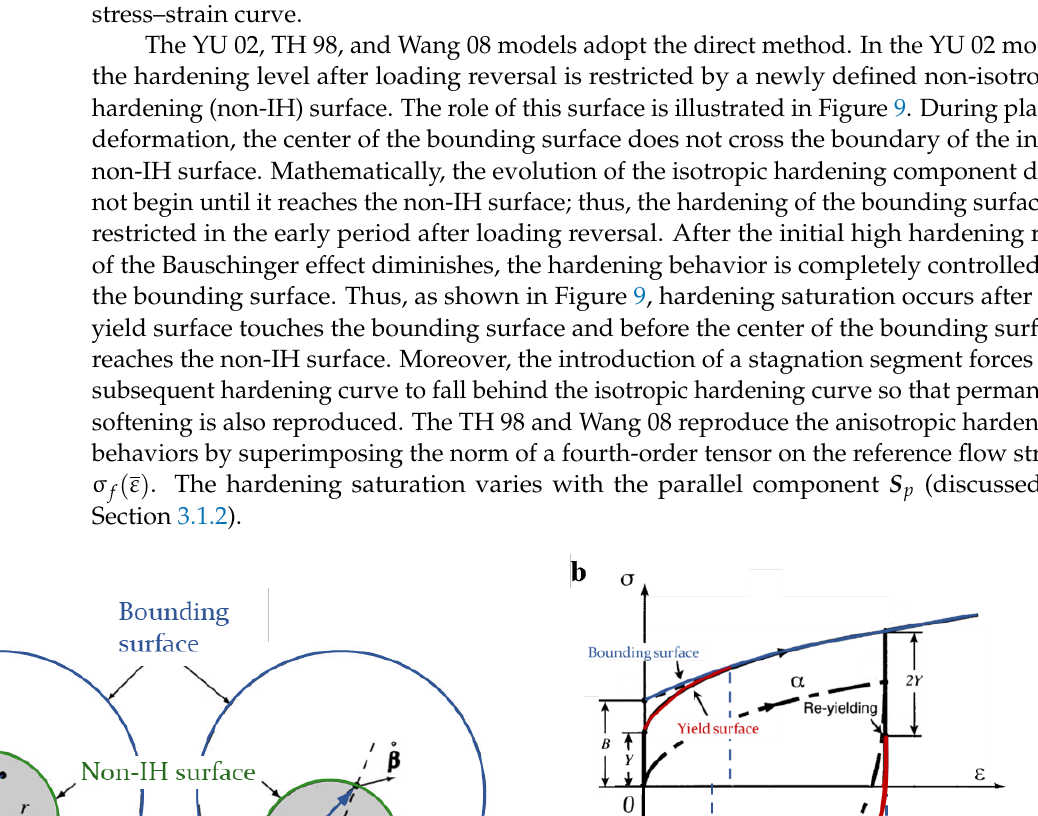
Figure 10. Evolution of the stress overshoot and its influence on transient hardening behaviors after the loading reverses in the QHH 18 model.